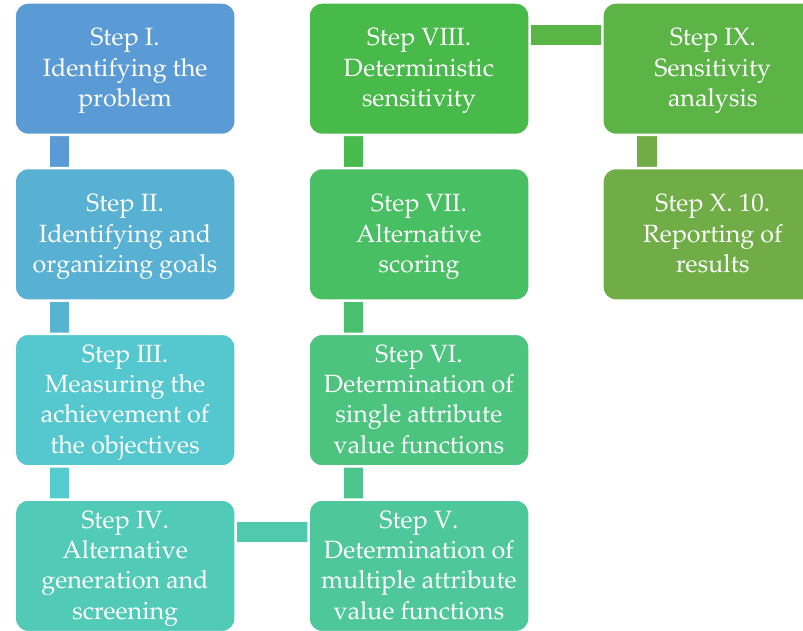
Figure 2. Ten steps of the MODA analysis.